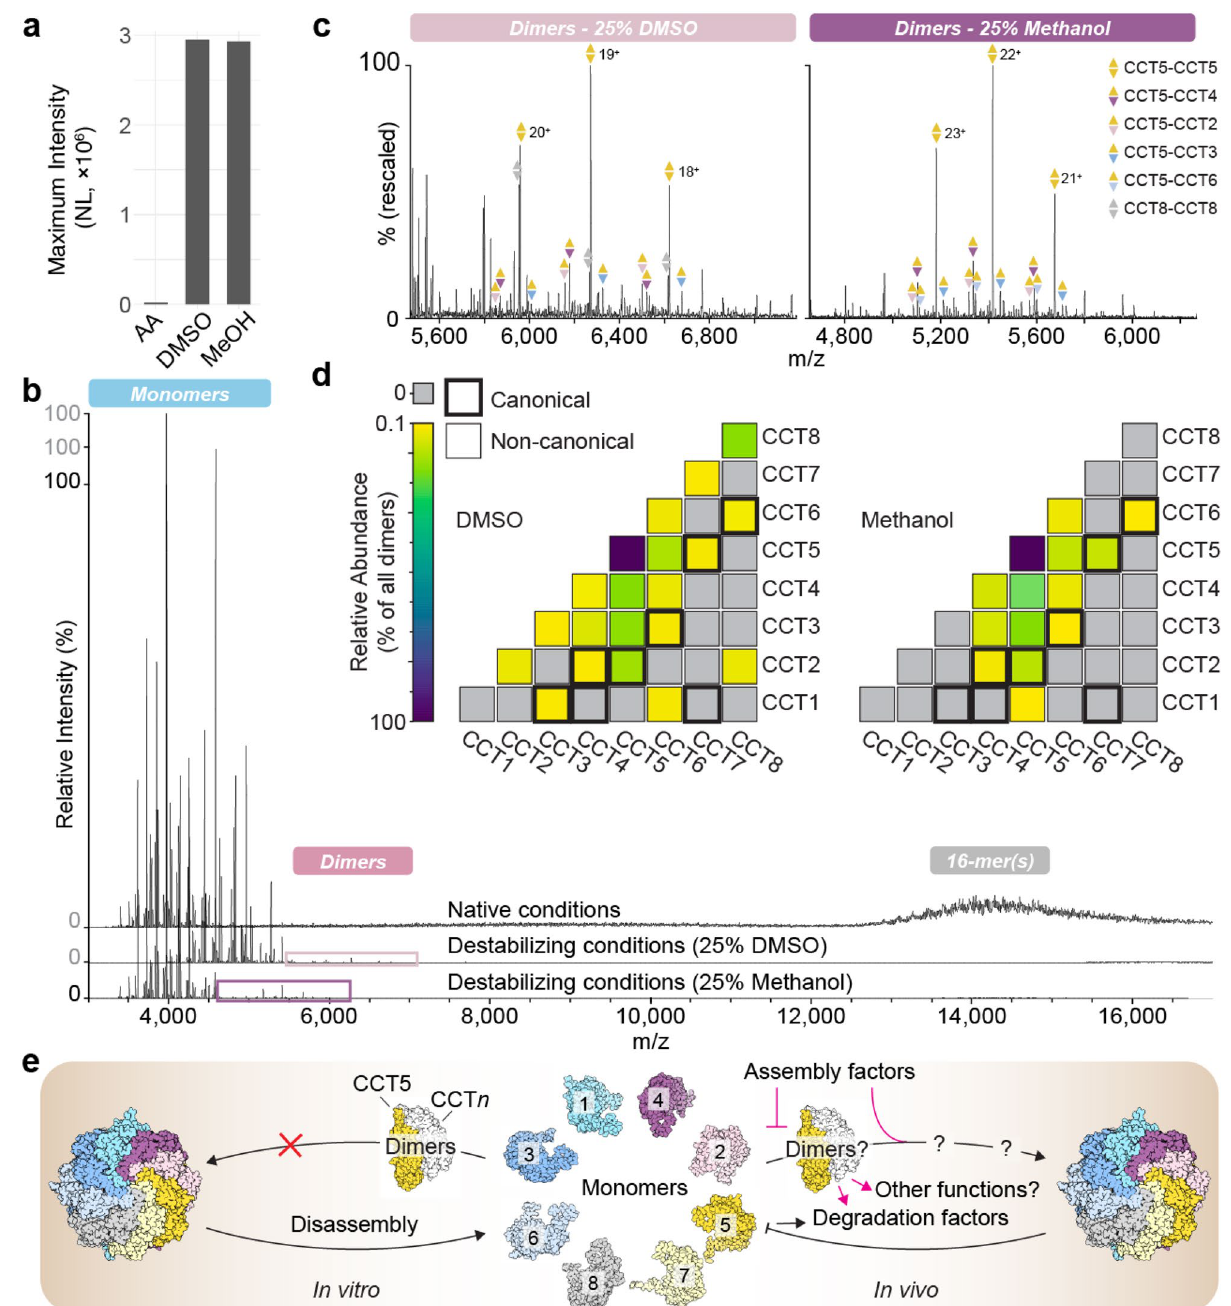
Figure 4. Chemical disruption of the hTRiC 16-mer enables subsequent dimerization. ( a ) The monomer signal intensity of the same hTRiC sample increases over 100-fold upon addition of 25% DMSO or methanol (MeOH) (NL = Normalized Level). This supports the original presence of predominantly intact 16-mers and their thorough dissociation into monomers. ( b ) Native mass spectra of intact and solution-dissociated hTRiC. Monomer, dimer, and 16-mer regions of signal are observed. ( c ) Detail view of the dimer regions in b. Peaks are sufficiently resolved to assign dimers unambiguously; three charge states for the five most abundant assigned dimers are annotated in each mass spectrum. ( d ) Relative abundances of all assigned CCT dimers after DMSO or methanol dissociation. Squares with a bold outline represent interfaces that exist in correctly assembled TRiC. The underlying data and quantification of each subunit’s contribution to the total dimer intensity is provided in Supplementary Data 4. ( e ) Schematic of TRiC assembly and dissociation in vitro and in vivo, where CCT5 is posited to play a key role in processes involving